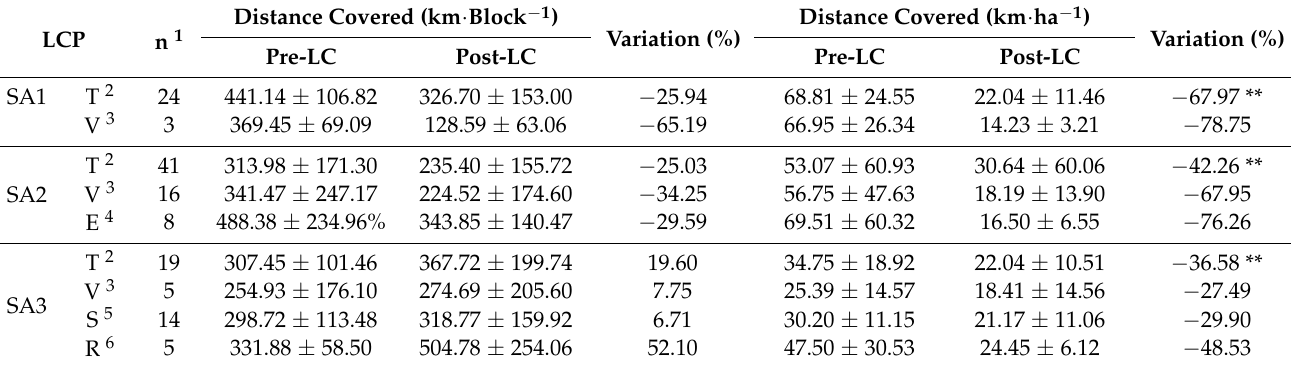
Table 5. Distances per block and hectare in situations pre and post-land consolidation.